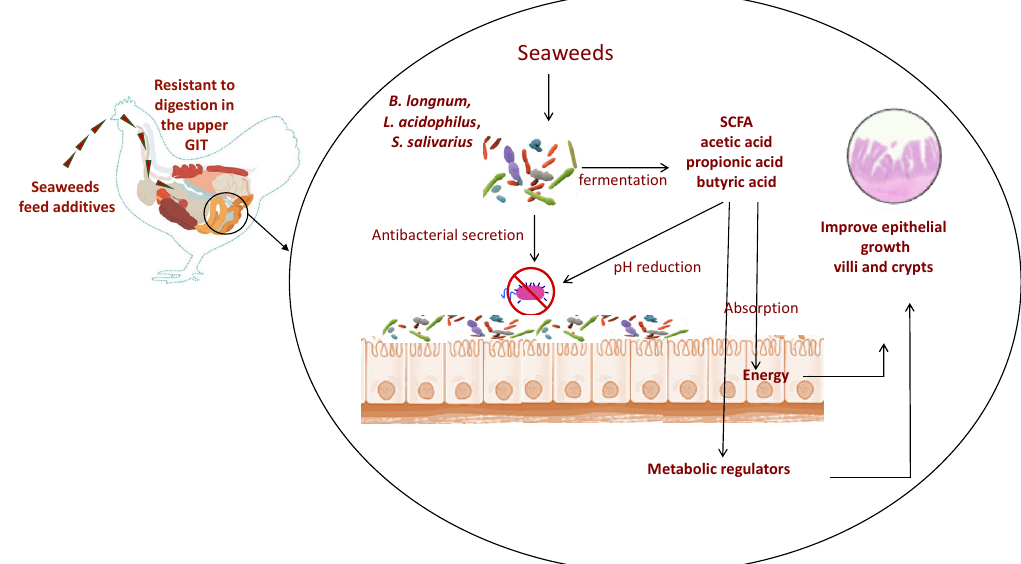
Figure 6. Modes of action of selected seaweeds as prebiotics for poultry health. Seaweeds are resistant to digestion in the upper gastrointestinal tract of chickens. After entering the colon, they are selectively fermented by beneficial microbiota, resulting in their increased numbers as well as the reduction of pathogenic bacteria by competitive exclusion. Beneficial microbes are known to produce short chain fatty acids and secrete anti-microbial peptides such as bacteriocins whilst also helping in the differentiation and proliferation of enterocytes, all of which improves epithelial growth in addition to exhibiting immunomodulatory effects (redesigned from [89]).